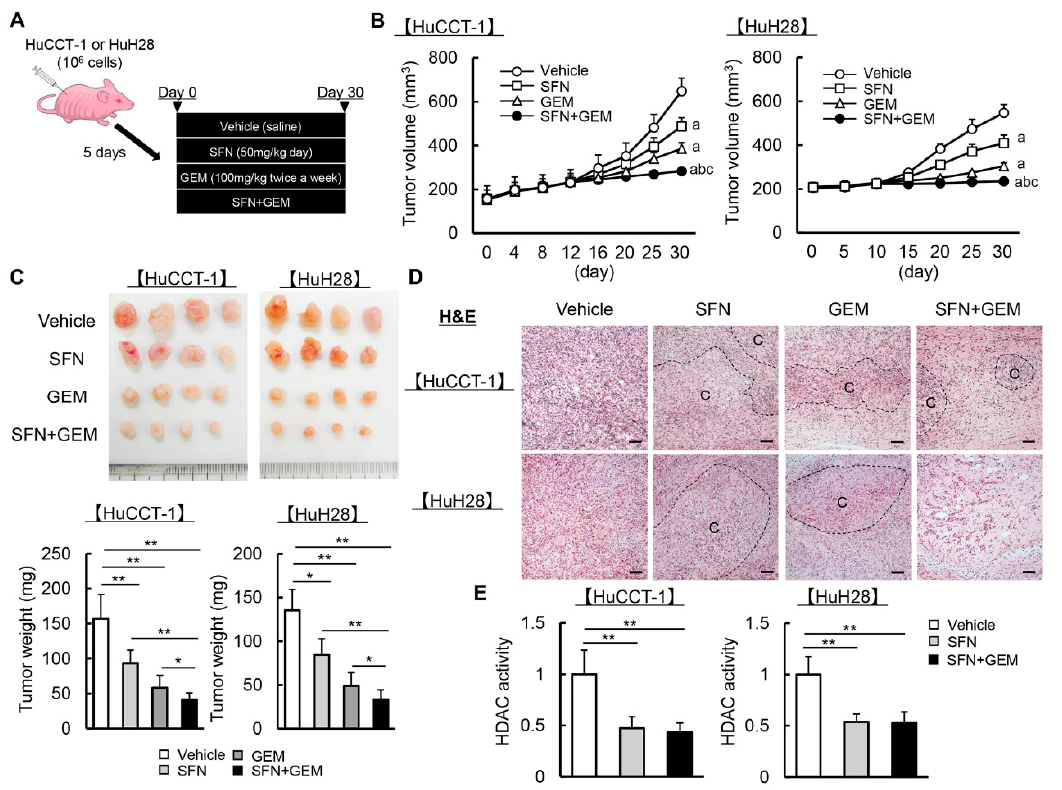
Figure 5. iCCA-derived xenograft tumor growth by treatment with SFN and GEM.( A ) Experimental protocol. ( B ) Time course of HuCCT-1 and HuH28-grafted tumor volumes. ( C ) Representative images and weights of resected tumors at the end of the experiment. ( D ) Representative pictures of HuCCT-1 and HuH28-grafted subcutaneous tumors stained with H&E. C; cancerous lesions, Scale bar; 100 µ m. ( E ) HDAC activity in the resected subcutaneous tumor tissues. The values are shown as fold changes to the vehicle-treated group ( E ). Data are mean ± SD ( n = 20 tumors/10 mice; B , C , E ). a p < 0.01, b p < 0.01, c p < 0.01 compared with the group treated with Veh, SFN or GEM, respectively at the end of the experiment ( B ). * p < 0.05, ** p < 0.01, indicating a significant difference between groups ( C , E ).